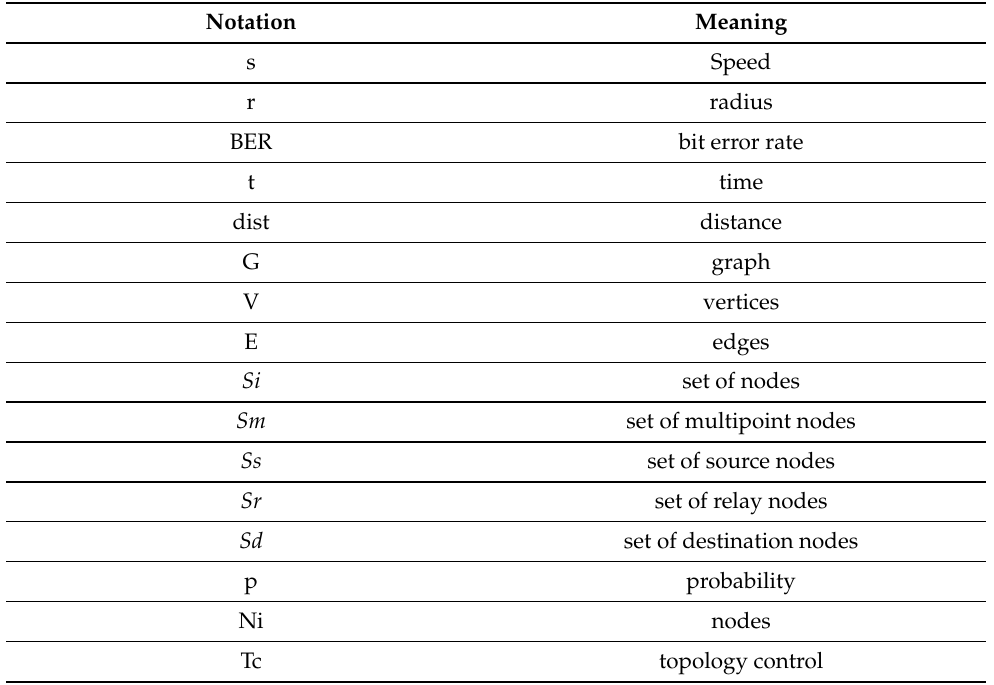
Table 1. Symbols used in mathematical